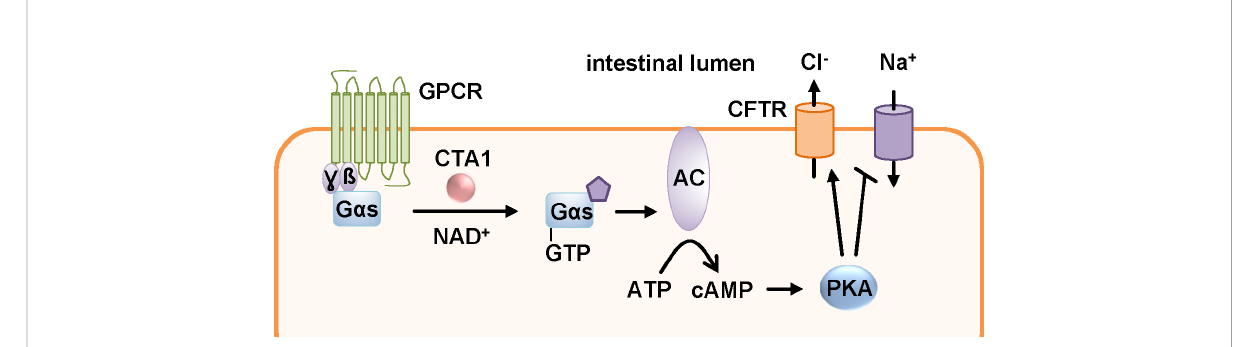
FIGURE 8 The enzyme subunit of cholera toxin, CTA1, ADP-ribosylates the a -subunits of stimulatory G proteins (G a s) of G protein coupled receptors (GPCR). This leads to a constitutively active adenylate cyclase (AC) and a massive increase in intracellular cAMP. Activation of protein kinase A (PKA) results in inactivation of sodium channels and stimulation of the cystic fi brosis transmembrane regulator (CFTR) leading to secretion of chloride ions into the intestinal lumen. This results in extensive water secretion causing the watery diarrhea characteristic of cholera (Haan and Hirst, 2004).